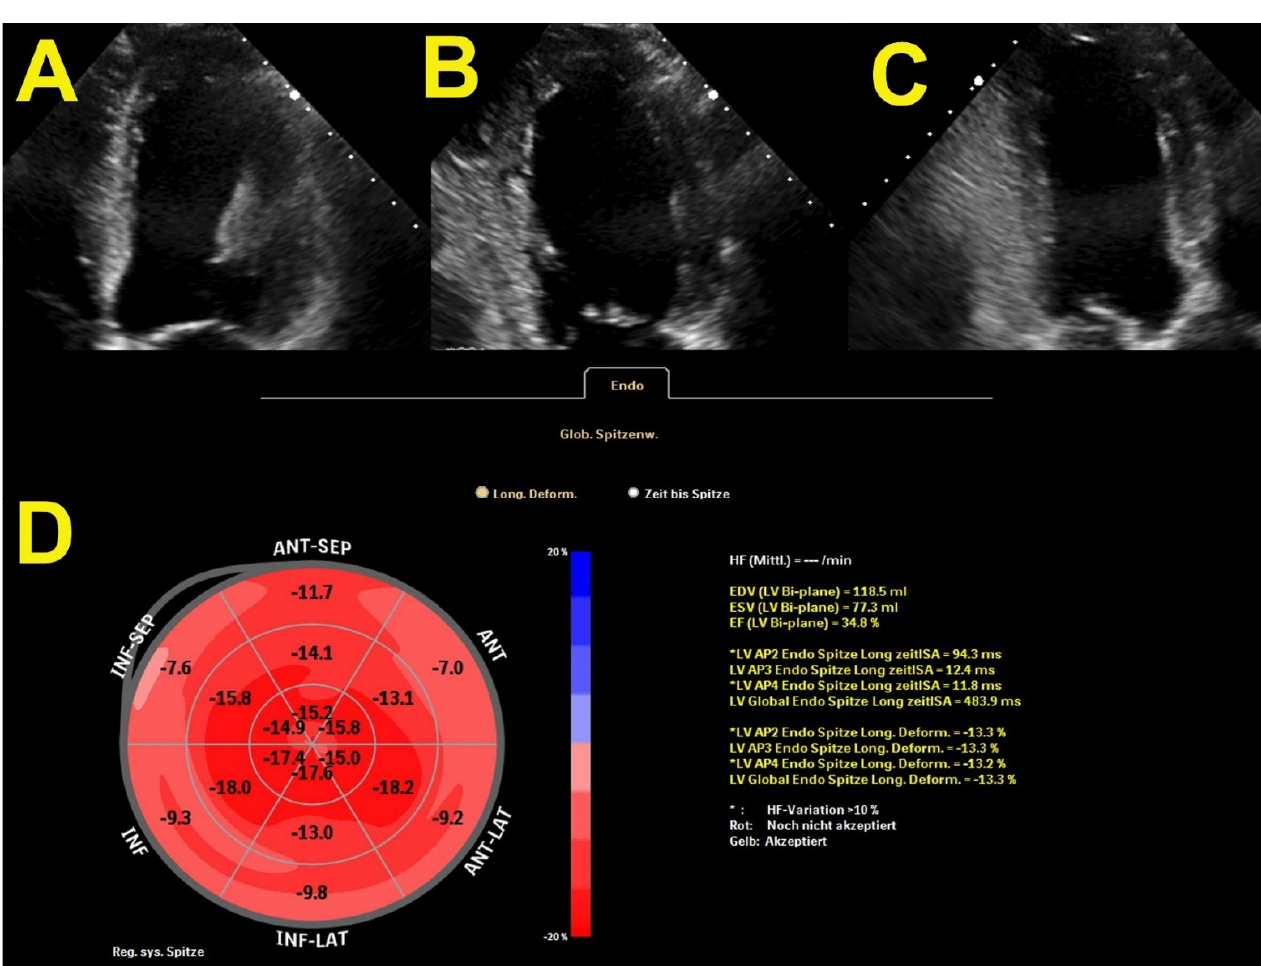
Figure 1. Echocardiographic assessment of left ventricular longitudinal strain with bullseye presen- tation. ( A ) 4-chamber view, ( B ) 2-chamber view, ( C ) 3-chamber view, ( D ) bullseye presentation of longitudinal strain of each myocardial segment. EDV—endi-diastolic volume, ESV—end-systolic volume, EF—ejection fraction, LV—left ventricicle, AP2—two-hamber view, AP3—three-chamber view, AP4—four-chamber view, ANT-anterior, SEP-septum, LAT-lateral, INF-inferior.